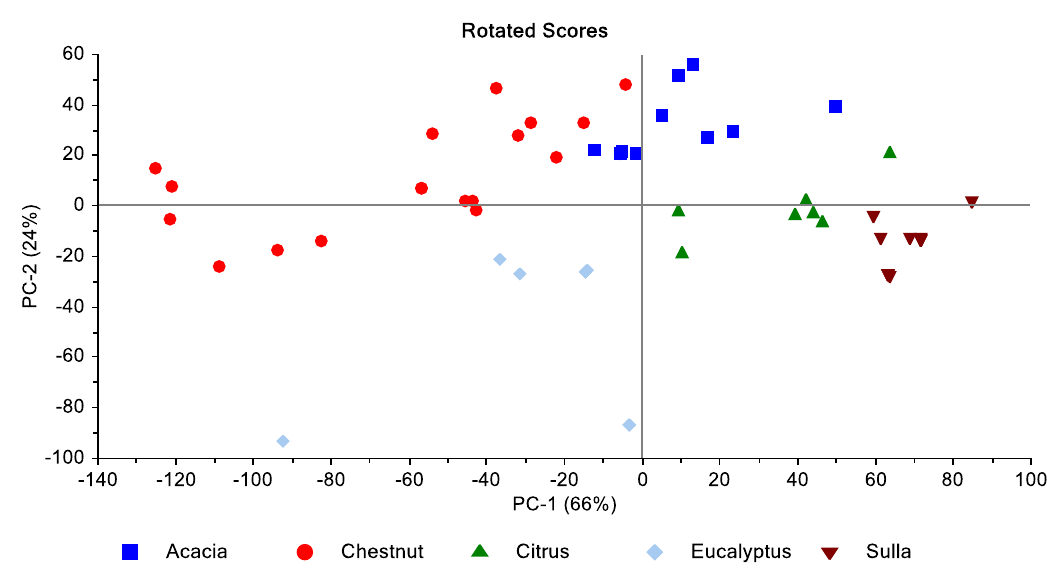
Figure 2. The principal component analysis (PCA) of honeys of Calabria classified on botanical origin.